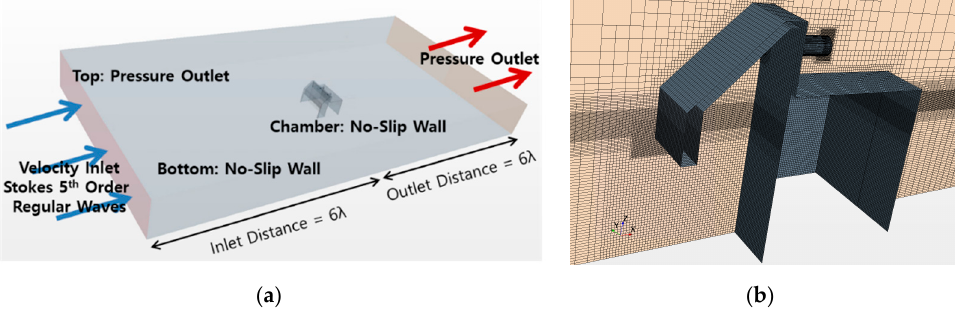
Figure 1. Computational fluid dynamics (CFD) simulation domain, boundary conditions, and grid system. ( a ) Domain and boundary conditions; ( b ) Grid system.